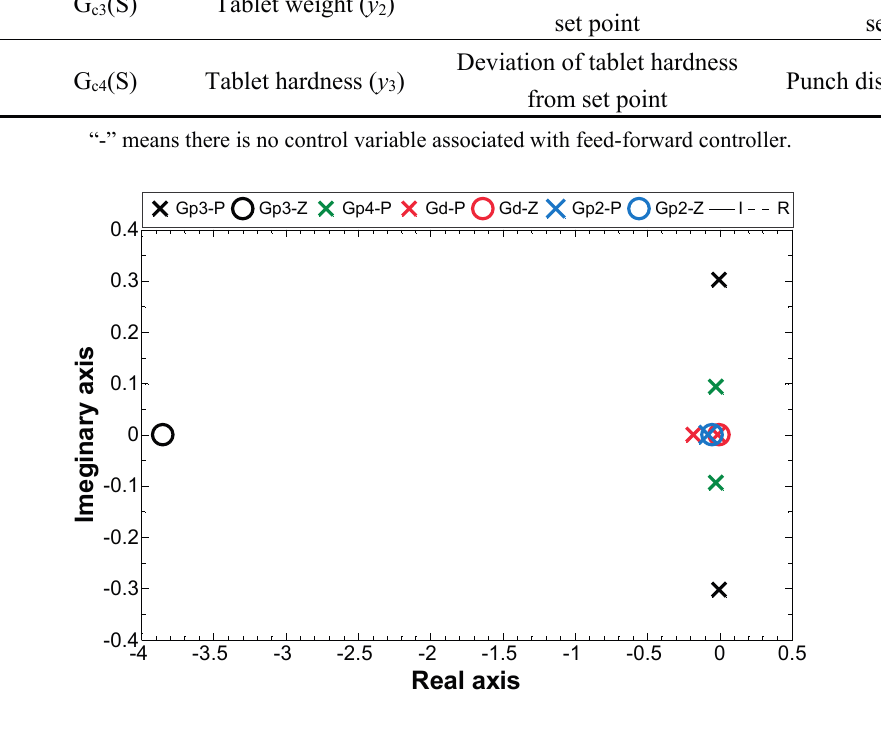
Figure 2. Poles (P)-zeros (Z) plot of transfer function